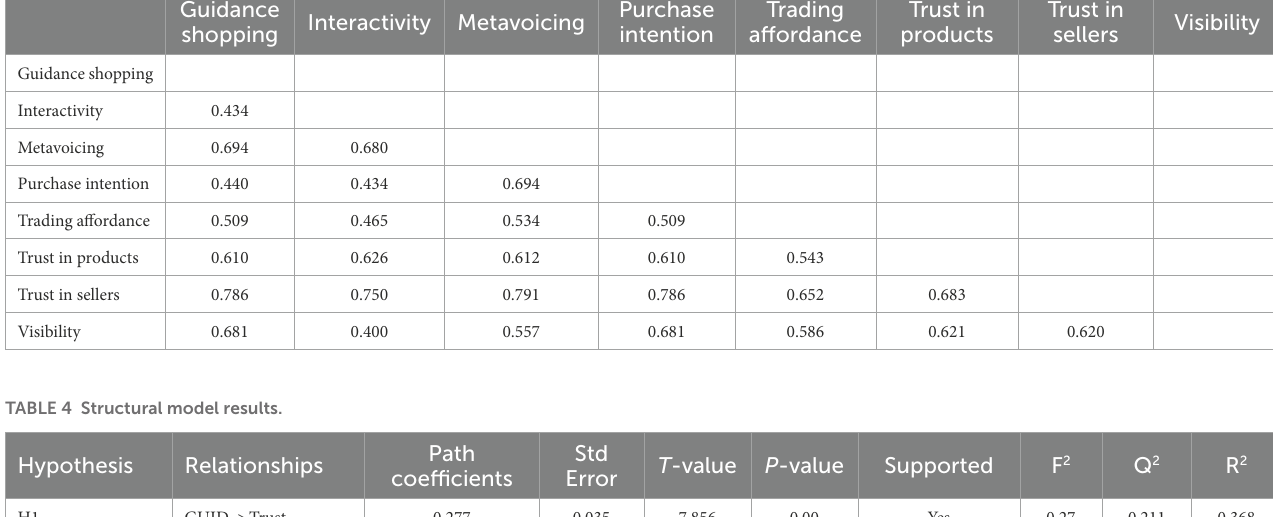
Guidance shopping